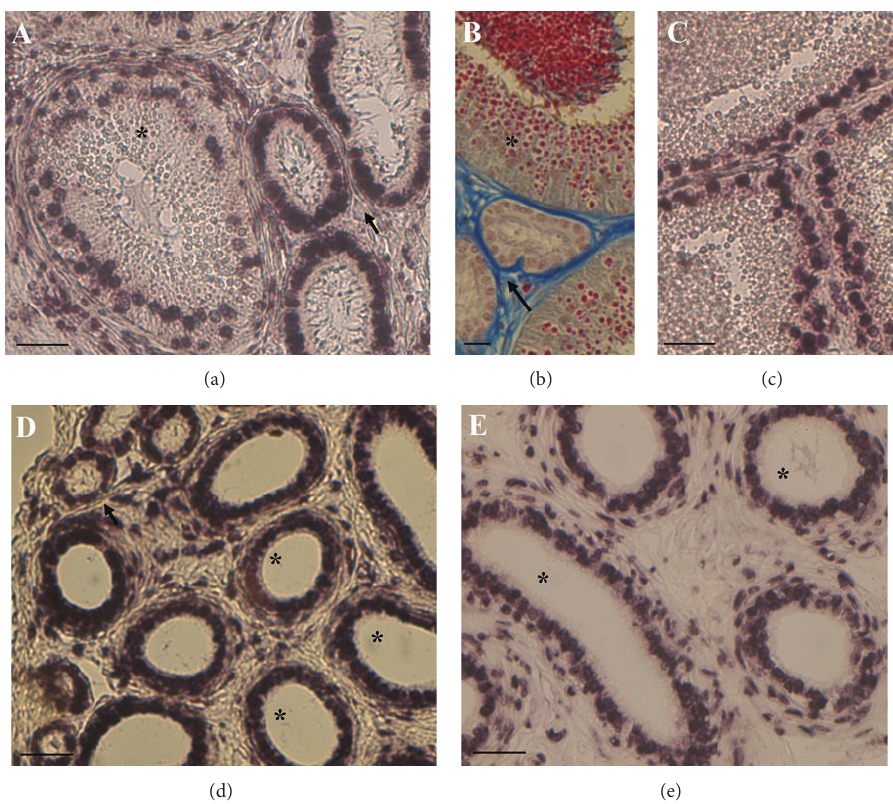
Figure2:ChangesinthemorphologyandunchangedexpressionofARintheepididymalchannelof Podarcis inthenaturalcycleorinsamples treated with E 2 during the mating period. (a) Mating period: positive signal for AR-mRNA in the epithelium of the efferent ductules ( ↑ ) and corpus ( ∗ ). (b) Staining with Mallory’s modified trichrome-mating period: note the ciliated cubic cells surrounding the efferent ductules ( ↑ ) and the elongated actively secreting cells of the corpus in which lumen is filled with secretory granules (red) and spermatozoa (dark blu). (c) Mating period: positivity for AR-mRNA in the cauda . (d) Winter stasis: both the efferent ductules ( ↑ ) and the corpus ( ∗ ) are still positive. (e) The nonsecretory epithelium of the corpus ( ∗ ) expresses AR-mRNA also in E 2 treated males in the mating period ( ∗ ). The bar is 30 𝜇